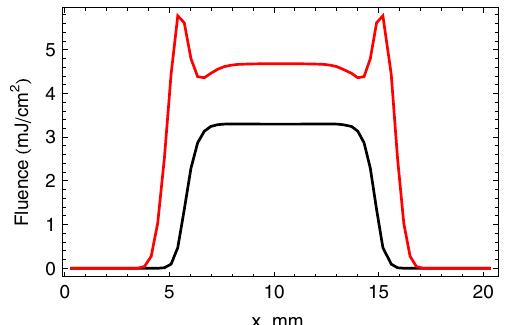
FIG. 9. Signal (black) and pump (red) beam profile after the second optical parametric amplifier, for a crystal length of 1.4 mm.